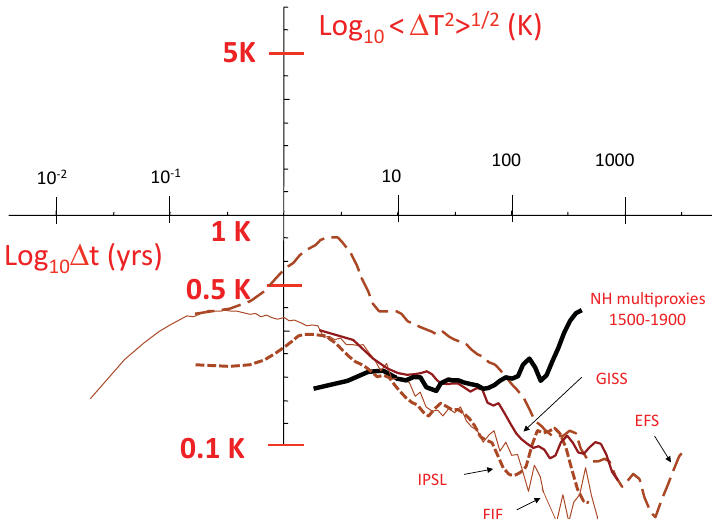
Fig. 4. Control runs versus preindustrial multiproxies: a comparison of the RMS Haar structure functions ( S(1t) ) for temperatures from the multiproxies Fig. 3 (resolution 1yr, black, 1500–1900) and GCM control runs (brown dashed, IPSL, EFS monthly), annual resolution GISS-E2-R, (thick brown, continuous) and the FIF stochastic model (thin brown). With the exception of the GISS-E2-R (land, Northern Hemisphere), the data are averaged over the entire globe. The IPSL curve is from a 500yr control run, the EFS is from a 3000yr control run; the “bump” at 2–4yr is a broad quasi periodic model artefact. The reference lines have slopes ξ (2)/2 so that β =1 + ξ (2)=0.2, 0.4, 1.8. The amplitude of the Haar structure functions have been calibrated using standard and tendency structure functions and are accurate to within ± 25% (a factor 2 was